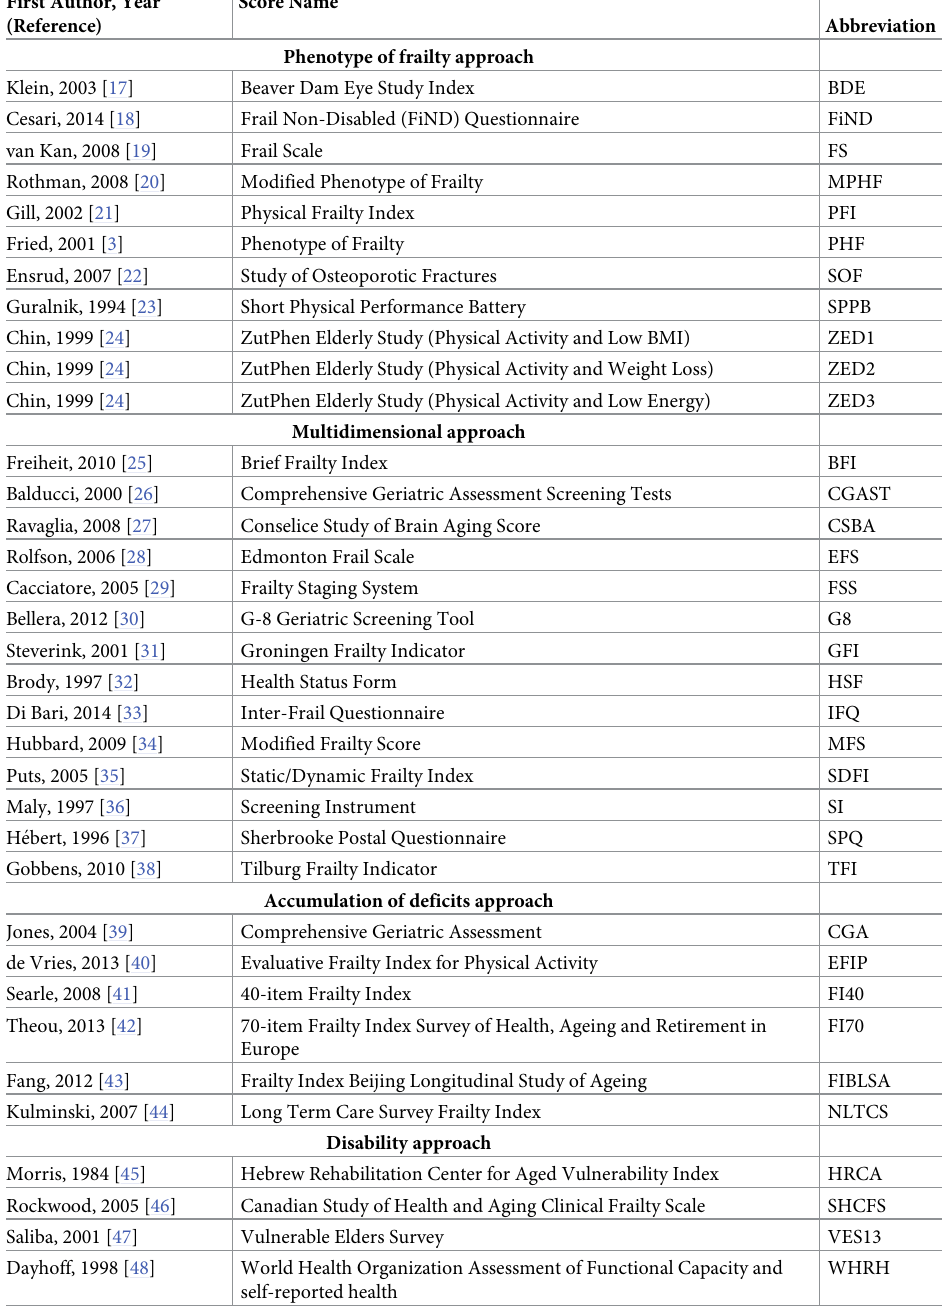
Table 1. Frailty scores calculated in participants of ELSA wave 2